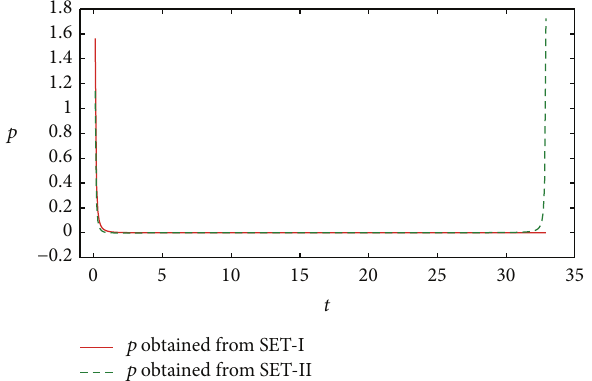
= 1, 𝑅 = 1, 𝑛 = 1 . 6, and 1 1